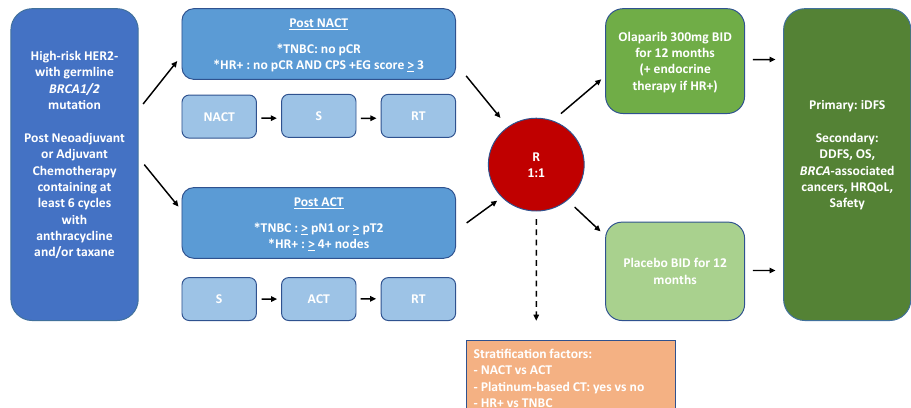
Fig. 1 Schema of the OlympiA trial. NACT neoadjuvant chemotherapy, ACT adjuvant chemotherapy, S surgery, RT radiation therapy, HR + hormone receptor-positive, TNBC triple-negative breast cancer, R randomized, iDFS invasive disease-free survival, DDFS distant disease-free survival, OS overall survival, HRQoL health-related quality of life, CT